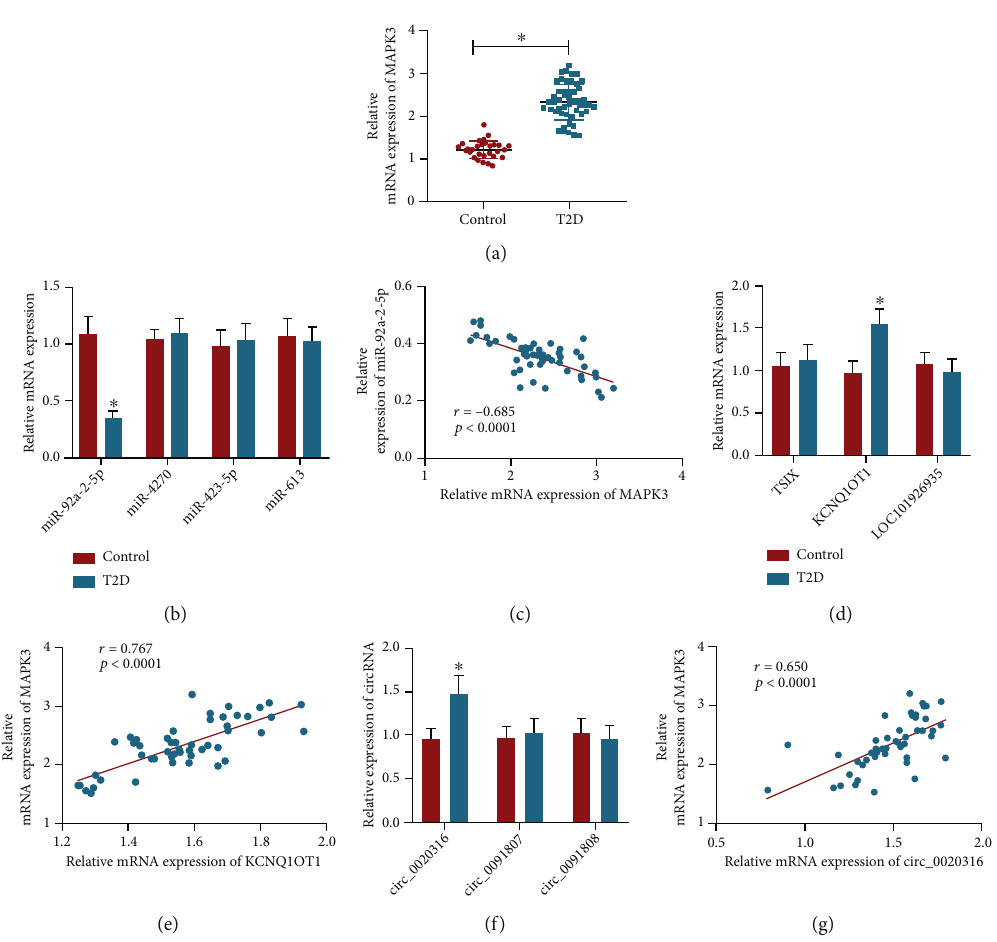
Figure 6: KCNQ1OT1, circ_0020316, and MAPK3 are upregulated, but miR-92a-2-5p is downregulated in peripheral blood of T2DM patients with macroangiopathy. (a) RT-qPCR detection of MAPK3 mRNA expression in peripheral blood of 50 T2DM patients with macroangiopathy and 30 normal healthy controls. (b) miR-4270, miR-92a-2-5p, miR-423-5p, and miR-613 expressions determined in peripheral blood of 50 T2DM patients with macroangiopathy and 30 normal healthy controls by RT-qPCR. (c) Correlation between miR-92a-2-5p and MAPK3 expressions assessed by Pearson ’ s methods. (d) TSIX, KCNQ1OT1, and LOC101926935 expressions in peripheral blood of 50 T2DM patients with macroangiopathy and 30 normal healthy controls measured by RT-qPCR. (e) Correlation between KCNQ1OT1 and MAPK3 expressions assessed by Pearson ’ s methods. (f) circ_0020316, circ_0091807, and circ_0091808 expressions in peripheral blood of 50 T2DM patients with macroangiopathy and 30 normal healthy controls measured by RT-qPCR. (g) Correlation between circ_0020316 and MAPK3 expressions evaluated by Pearson ’ s methods. ∗ p < 0 : 05 , compared with normal healthy